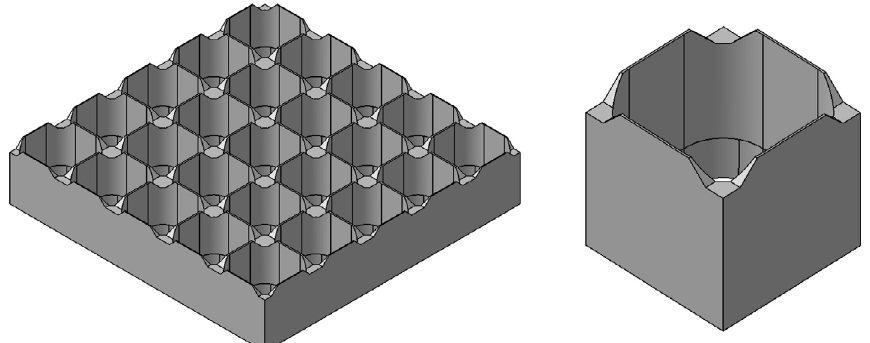
Figure 6. The rebuilt CAD model of periodic resin configuration.